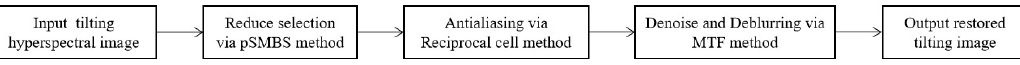
Figure 4. Flow chart of the optimal reciprocal cell combined the modulation transfer function (MTF) method.